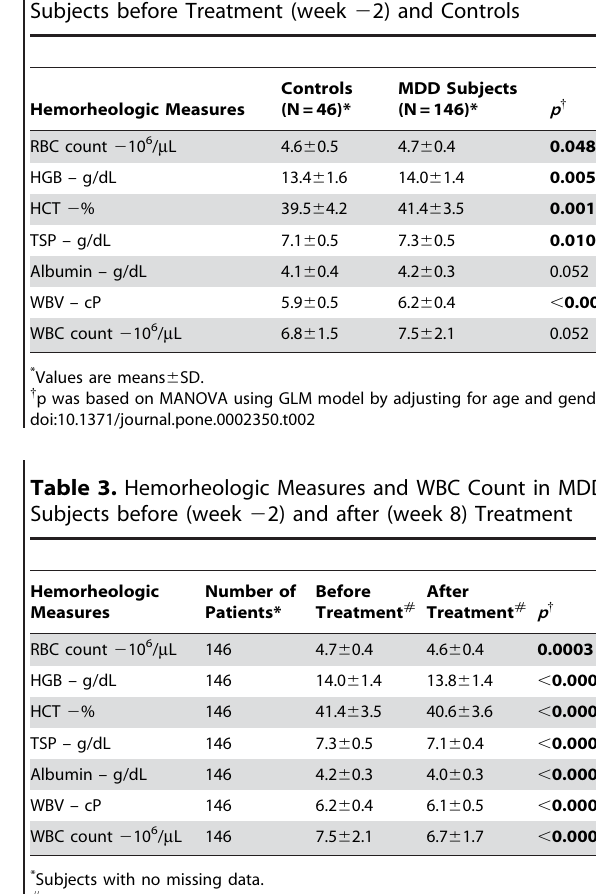
Hemorheologic Measures in Desipramine- and Measures of stress-hemoconcentration were not significantly different in subjects treated with desipramine or fluoxetine in MANOVA analysis. Our analyses showed that total RBC count, HBG, HCT, total WBC, TSP and albumin did not differ between the two groups in the final week of treatment.